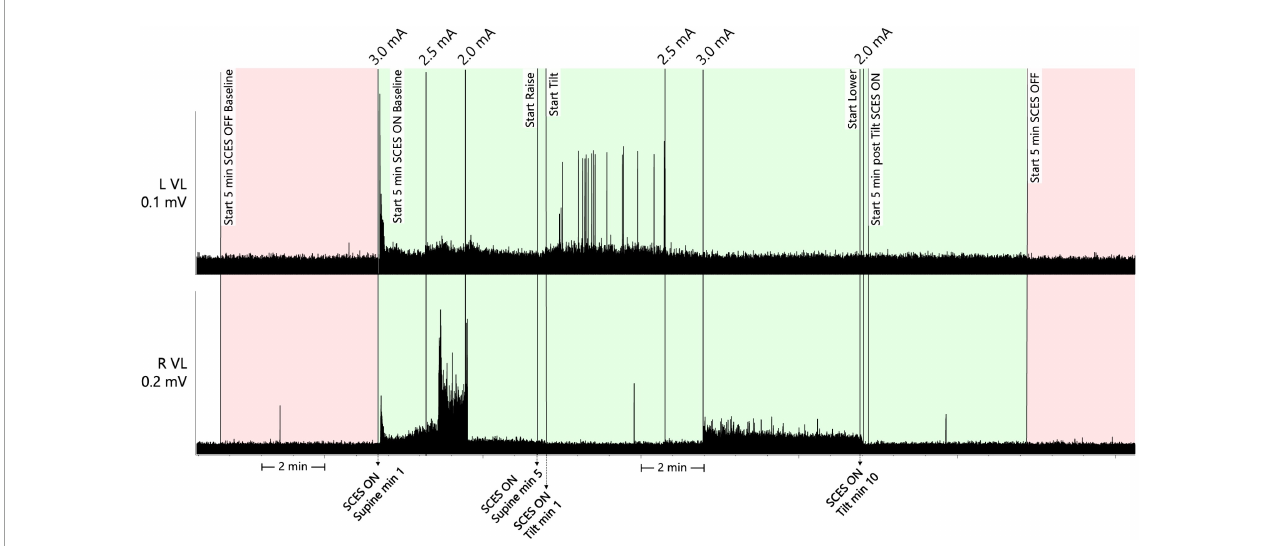
FIGURE4 Raw EMG activities of the left and right vastus lateralis muscles for 5 min with SCES off in supine position (pink), followed by 5 min in supine and 10 min tilt with SCES on (both green). The participant was then tilted back to supine position and the SCES remained on for another 5 min (green) followed by another 5 min with the SCES off (pink). The EMG activities were captured only during the second assessment period. min, minutes; mV, millivolts; mA, milliamps; SCES, spinal cord epidural stimulation.